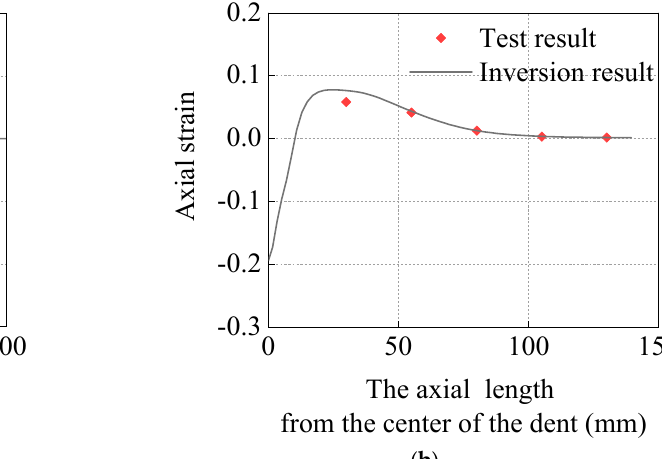
Figure 6. Comparison of strain results: ( a ) circumferential strain, ( b ) axial strain.